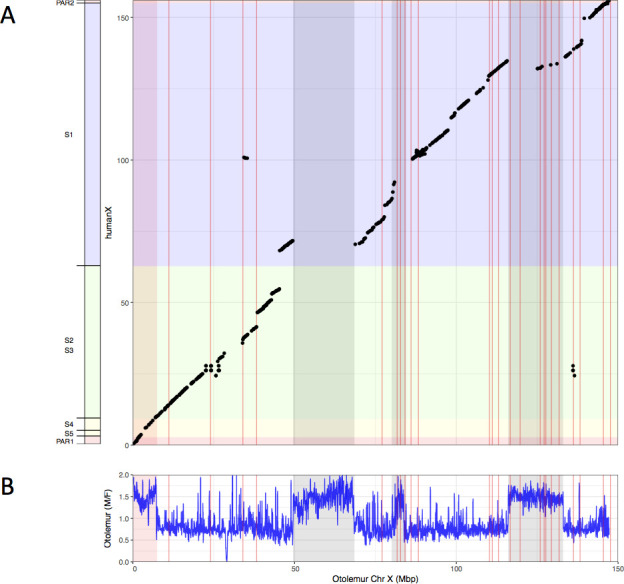
Synteny analysis of northern greater galago and human X chromosomes.(A) Synteny plot of the human and northern greater galago X chromosomes. (B) M:F read depth ratio along the northern greater galago X chromosome. See legend of Figure 1 for more details.